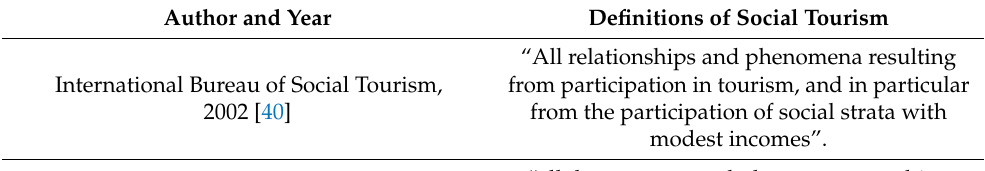
Table 4. Definitions of social tourism in the 21st century according to various authors and